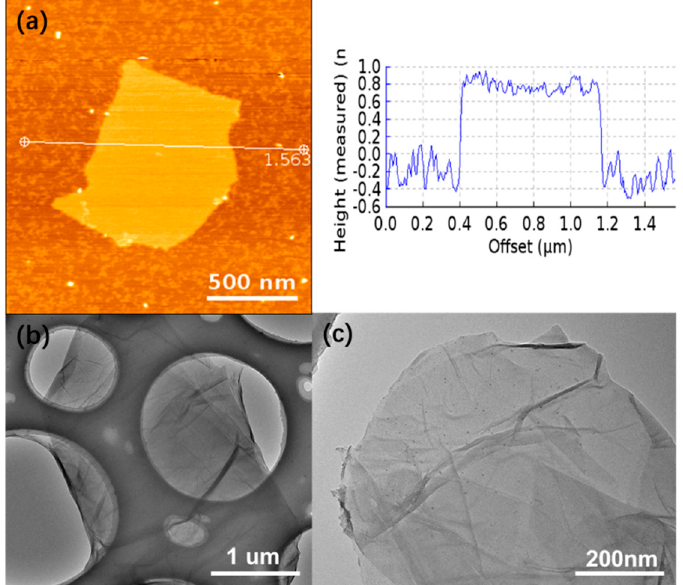
Figure 2. Morphological characterizations of GO and GO/AMT: ( a ) atomic force microscopy (AFM) height image of GO, ( b ) transmission electron microscopy (TEM) image of GO, and ( c ) TEM image of GO/AMT.